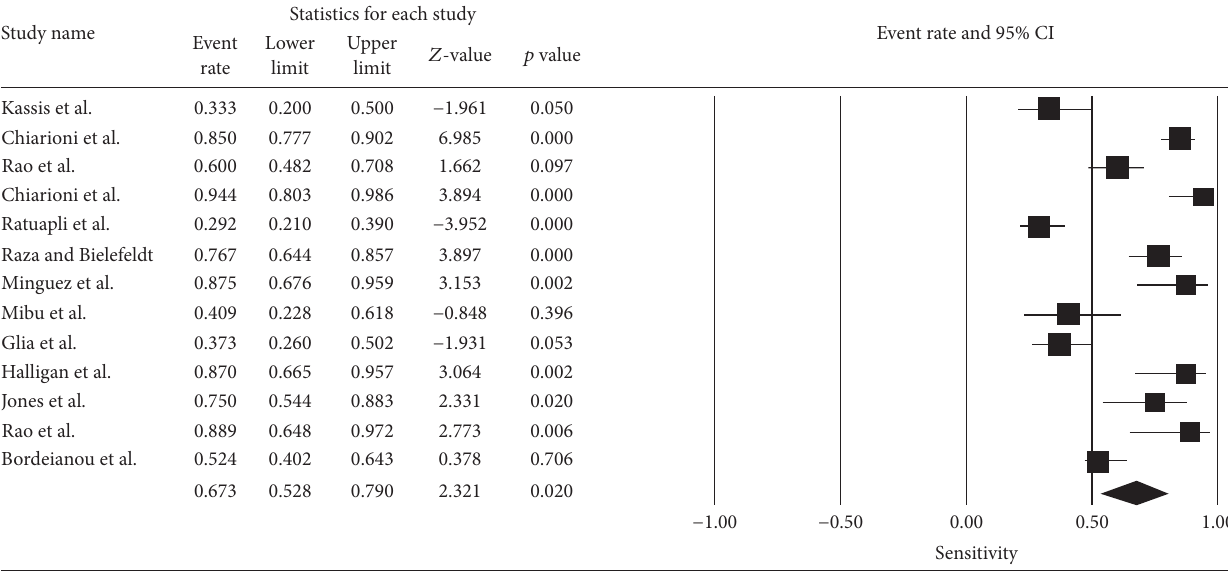
Figure 2: Summary measures for sensitivity of BET analysis.